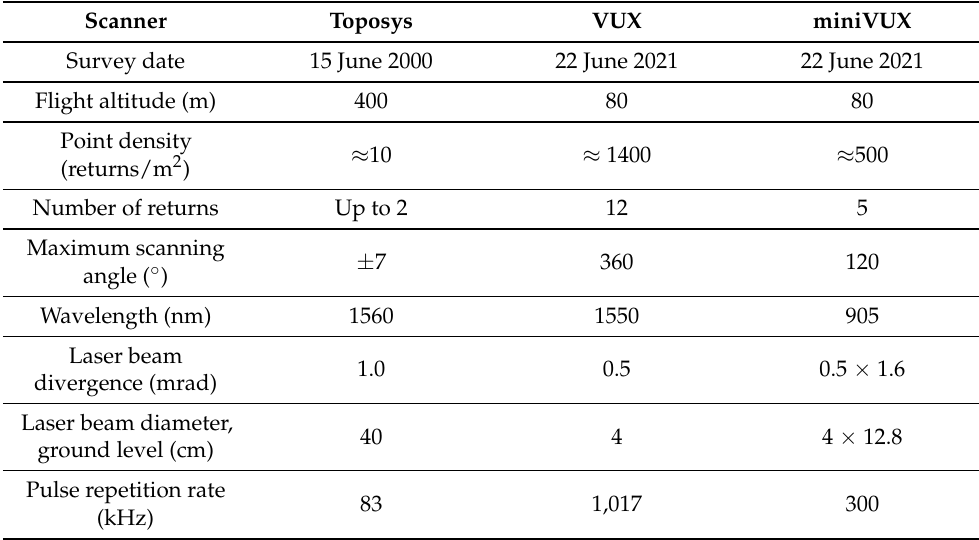
Table 2. The specifications of the ALS campaigns and devices used in the